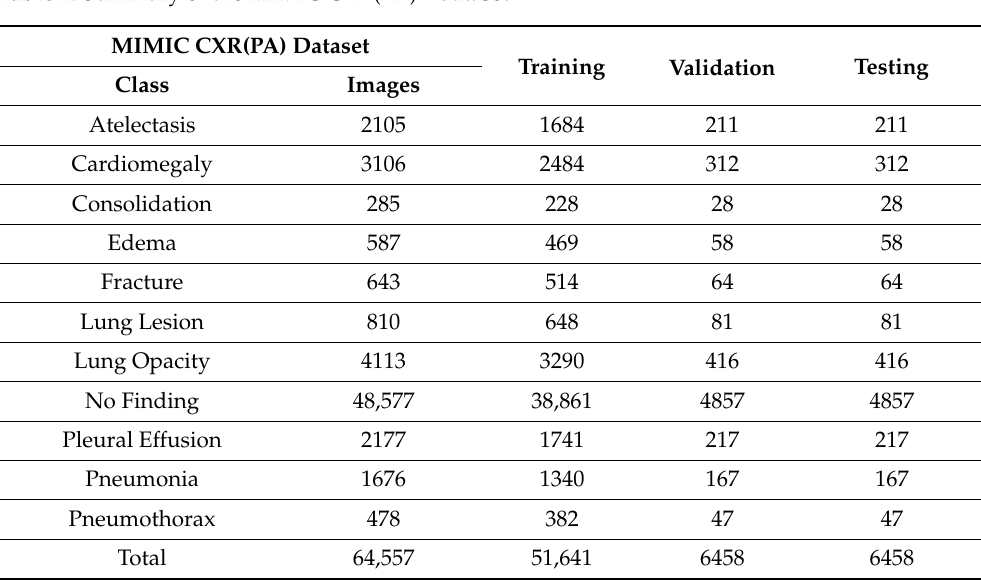
Table 2. Summary of the MIMIC CXR(PA) 1